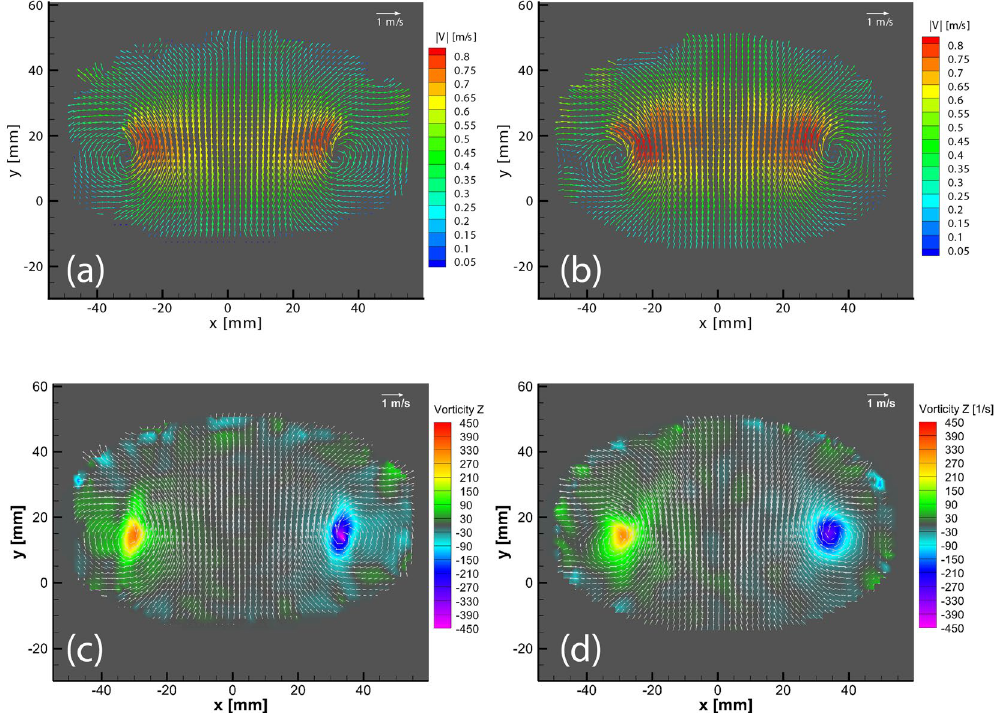
Figure 17. Side by side comparison of an instantaneous velocity field ( Δ t = 1300 μ s) between ( a ) stereo PIV system vs ( b ) smartphone Tomo PIV system, colored by the velocity magnitude. Comparison of contour plots of vorticity in Z between ( c ) stereo PIV system vs ( d ) smartphone Tomo PIV system (velocity vectors are included for further orientation reference). All images are presented in the plane Z = 0 mm.